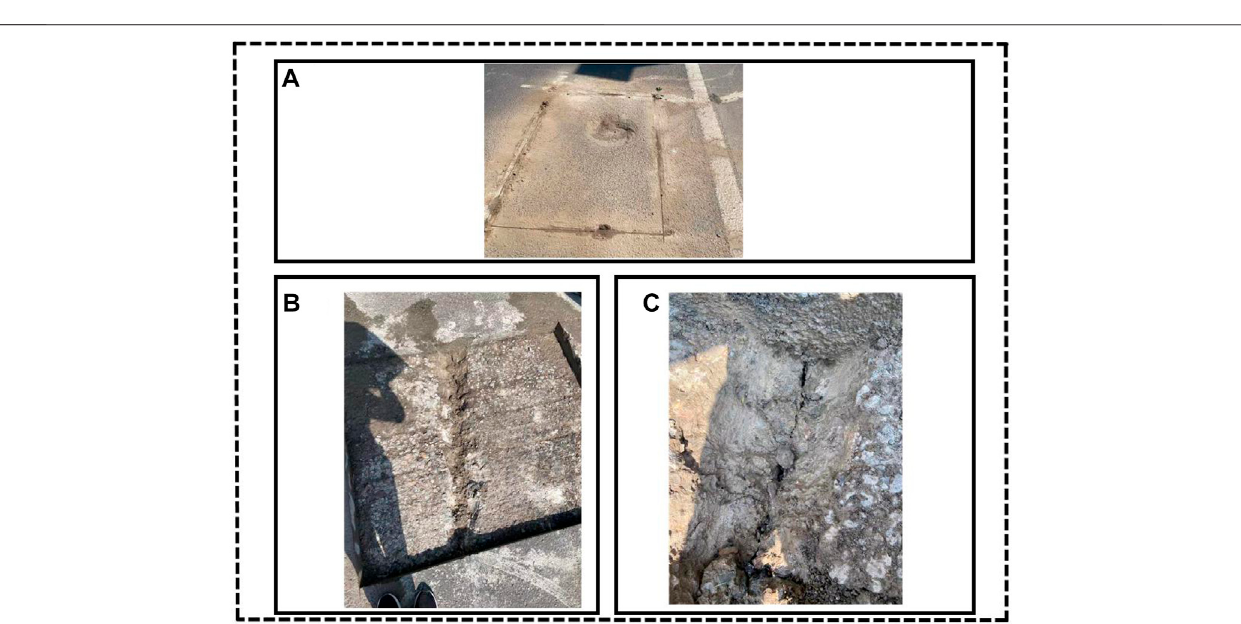
Frontiers in Materials |